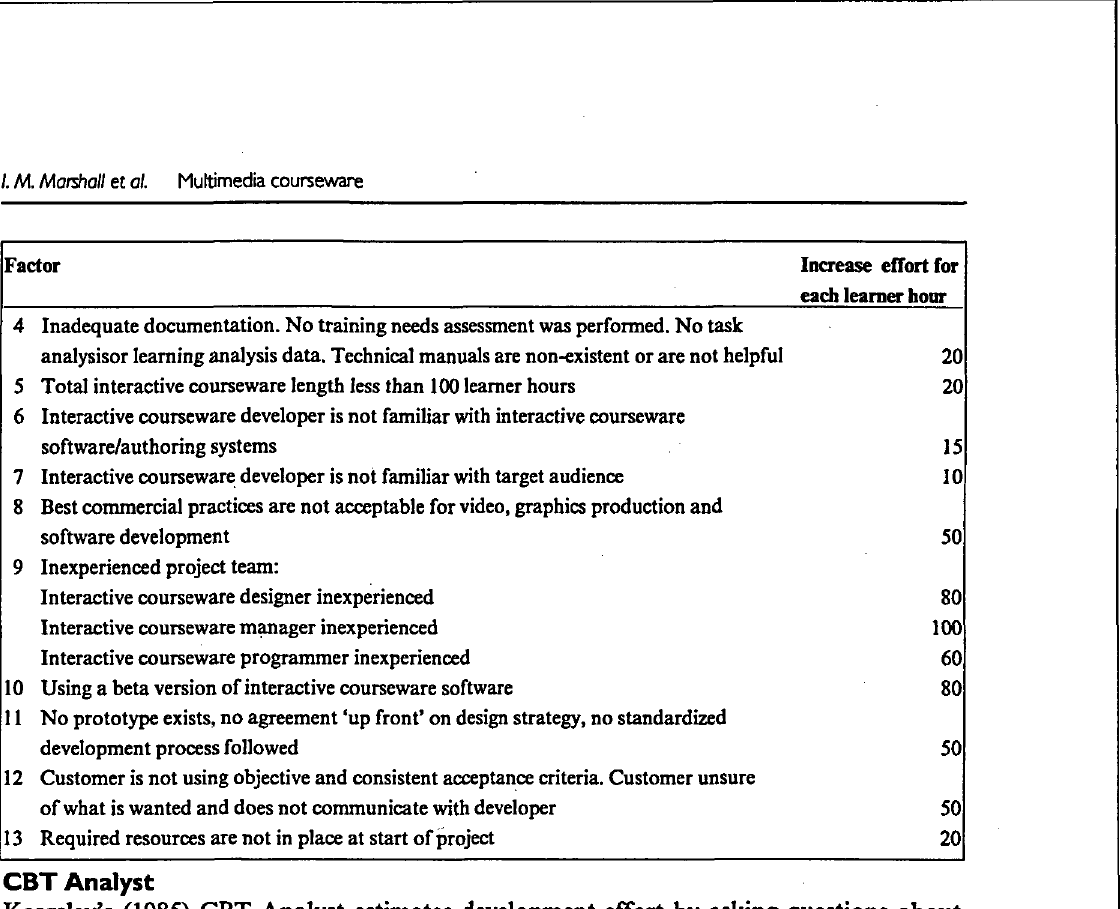
Table 4: CBT Analyst's base constraints